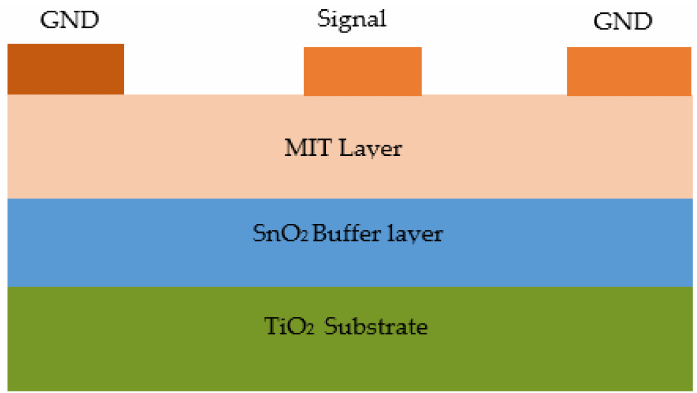
Figure 10. Schematic of epitaxial VO 2 based RF switches grown on SnO 2 /TiO 2 (001) substrate. Electrically Triggered RF